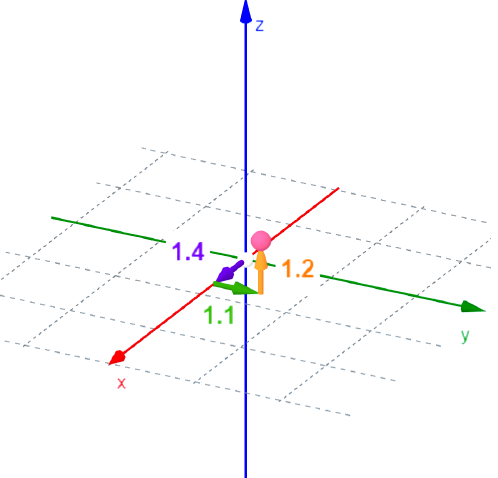
Figure 15. (1.4,1.1,1.2) node.